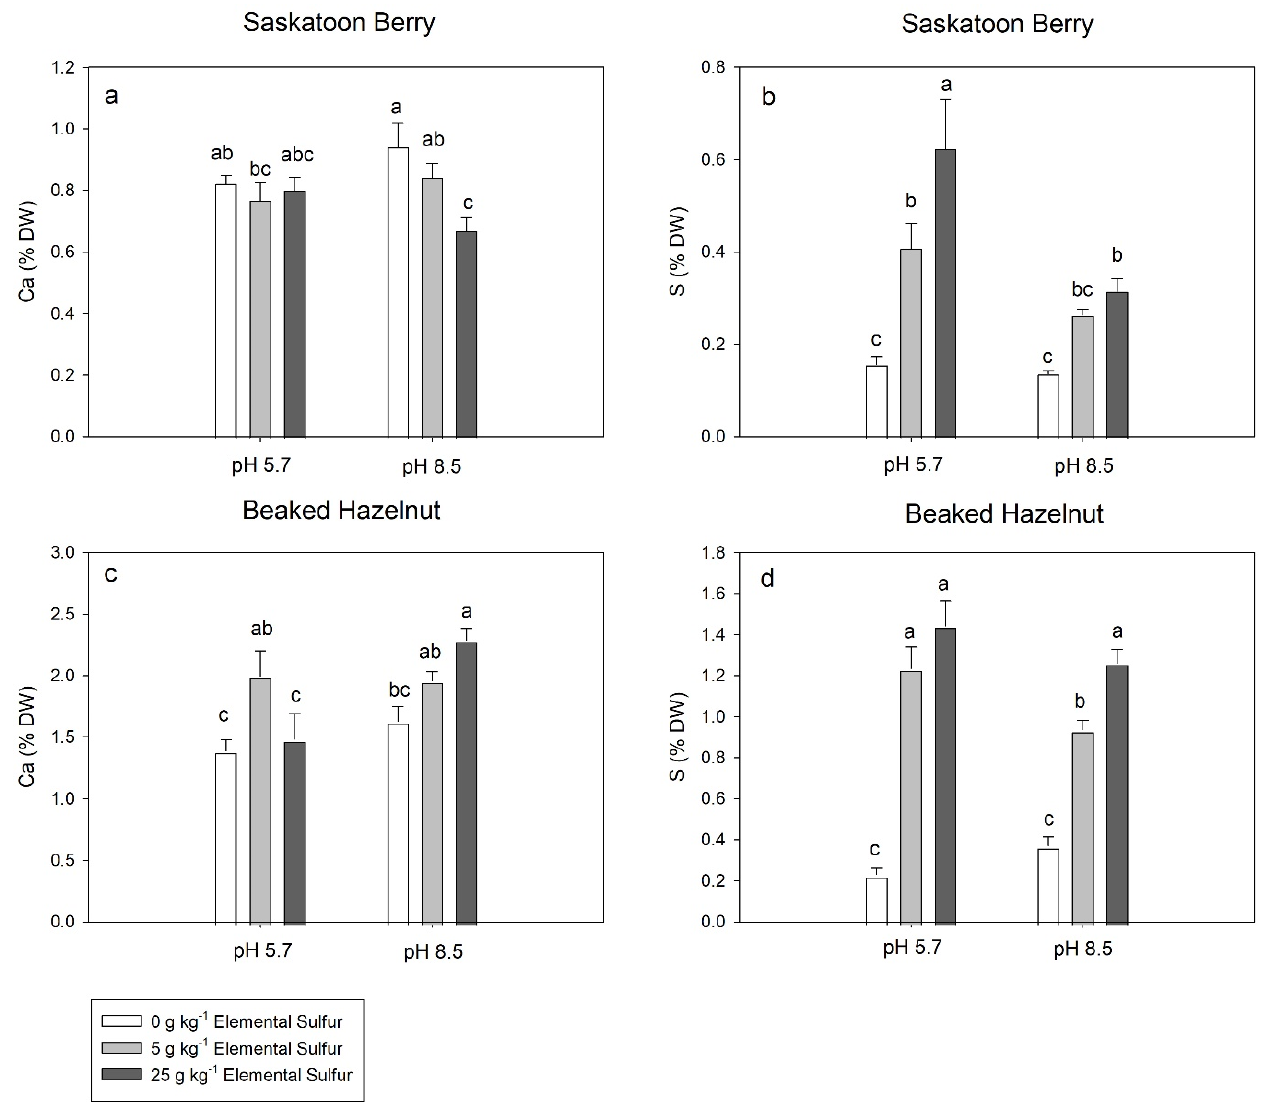
Figure 6. Leaf Ca and S concentrations in Saskatoon berry ( a , b ) and beaked hazelnut ( c , d ). Plants were grown for two months in the soil of the initial pH 5.7 and 8.5 that was supplemented with 0, 5, and 25 g kg − 1 elemental S. Different letters above the bars indicate significant differences ( α = 0.05) between treatments determined by Tukey HSD test. Means ( n = 6) ± SE are shown.